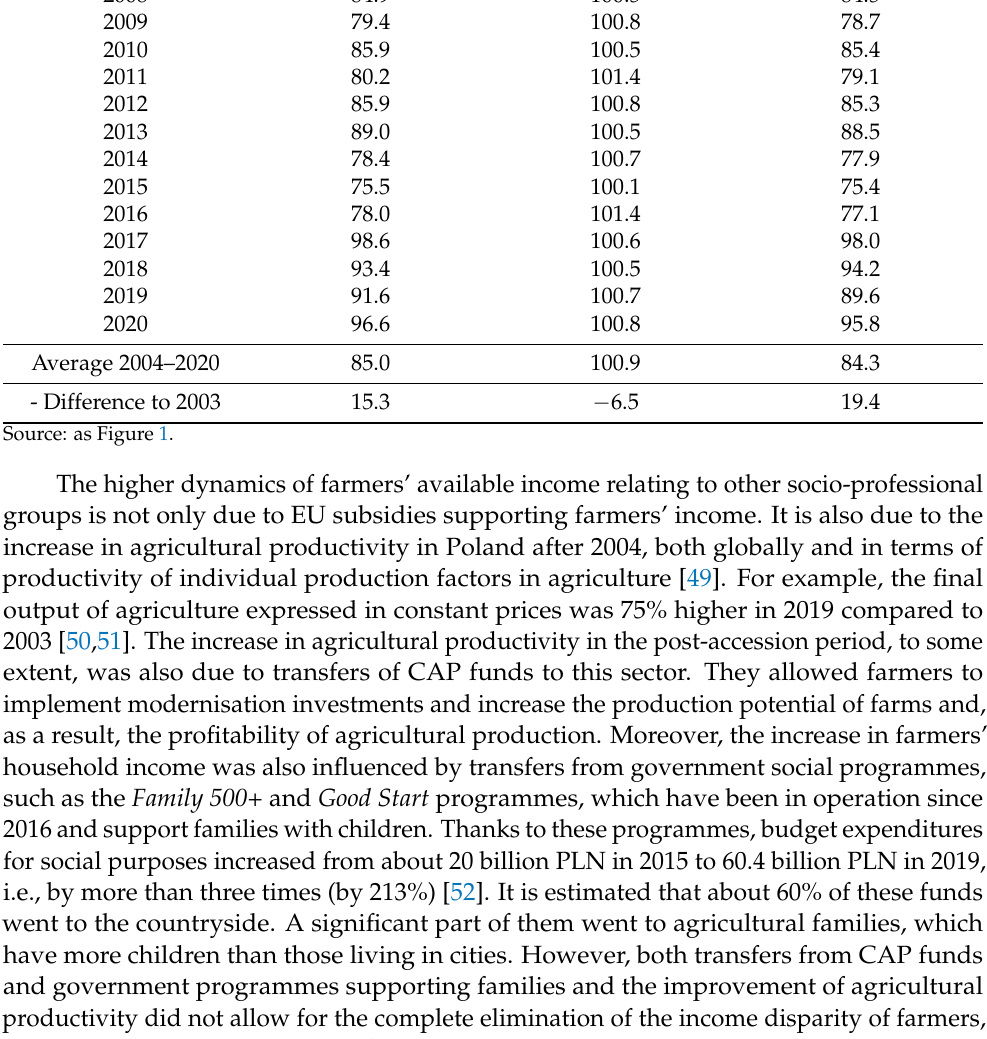
Farmers’ Income Parity in Relation to Employees (%)Farmers